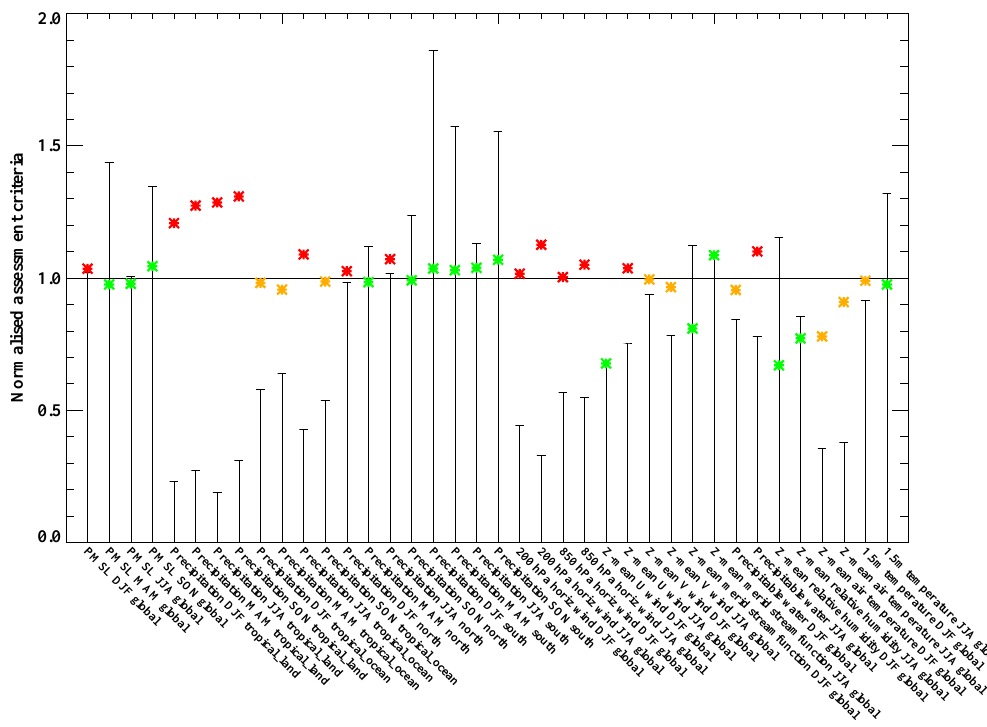
Fig. 6. Normalised assessment criteria (ratios of mean field root mean square errors) for a range of atmospheric fields from the GA4.0/GL4.0 N96-AL_clim simulation compared to a GA3.0/GL3.0 baseline. Statistics shown are from the seasons December to February (DJF), March to May (MAM), June to August (JJA) and September to November (SON) and for regions global, tropical land (land points between 30 ◦ N and 30 ◦ S), tropical ocean (ocean points between 30 ◦ N and 30 ◦ S), north (30 ◦ –90 ◦ N) and south (30 ◦ –90 ◦ S). The observation data sets used are HadSLP2 pressure at mean sea level (Allan and Ansell, 2006), GPCP precipitation (Adler et al., 2003), SSMI precipitable water (Wentz and Spencer, 1998) and CRUTEM3 1.5m temperature (Brohan et al., 2006), whilst the remaining climatologies are from ERA-Interim reanalyses (Berrisford et al., 2009). The whisker bars represent observational uncertainty, which is calculated by comparing the verifying data sets with alternative observations. These alternative data sets are ERA-40 pressure at mean sea level and precipitable water (Uppala et al., 2005), CMAP precipitation (Xie and Arkin, 1997), Legates and Willmott (1990) 1.5m temperature and MERRA reanalysis (Bosilovich, 2008) for the remaining